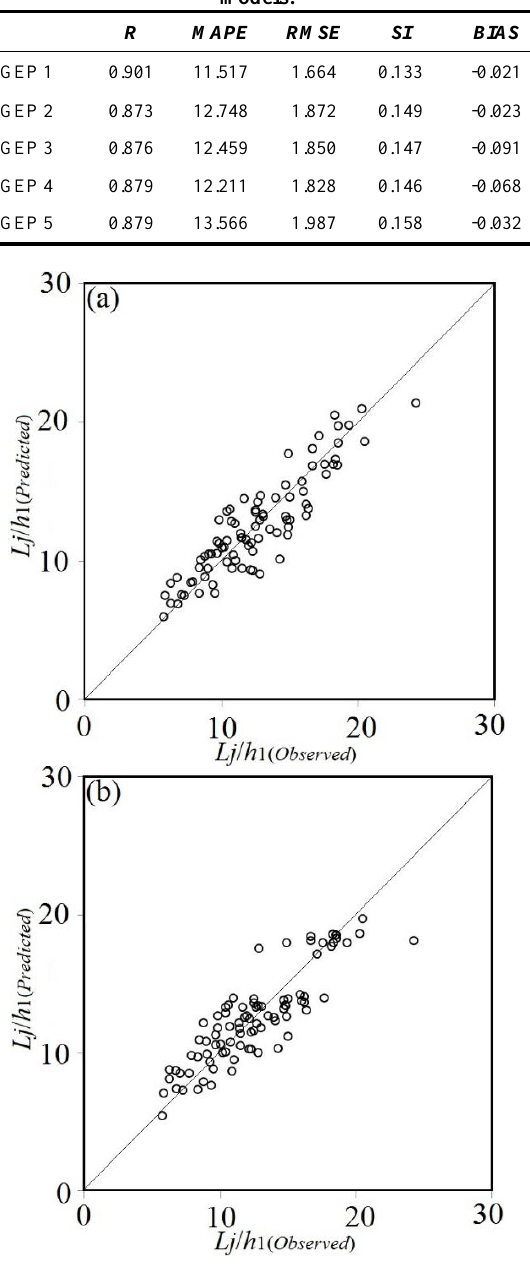
Table 3. Values of different statistical indices for GEP models.